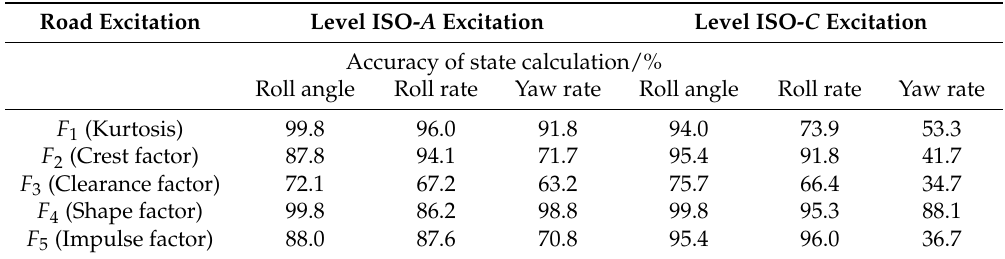
Table 8. Simulation accuracy of comparing 9-DOF model and CARSIM ® with steering wheel 5 ◦ input. Road Excitation